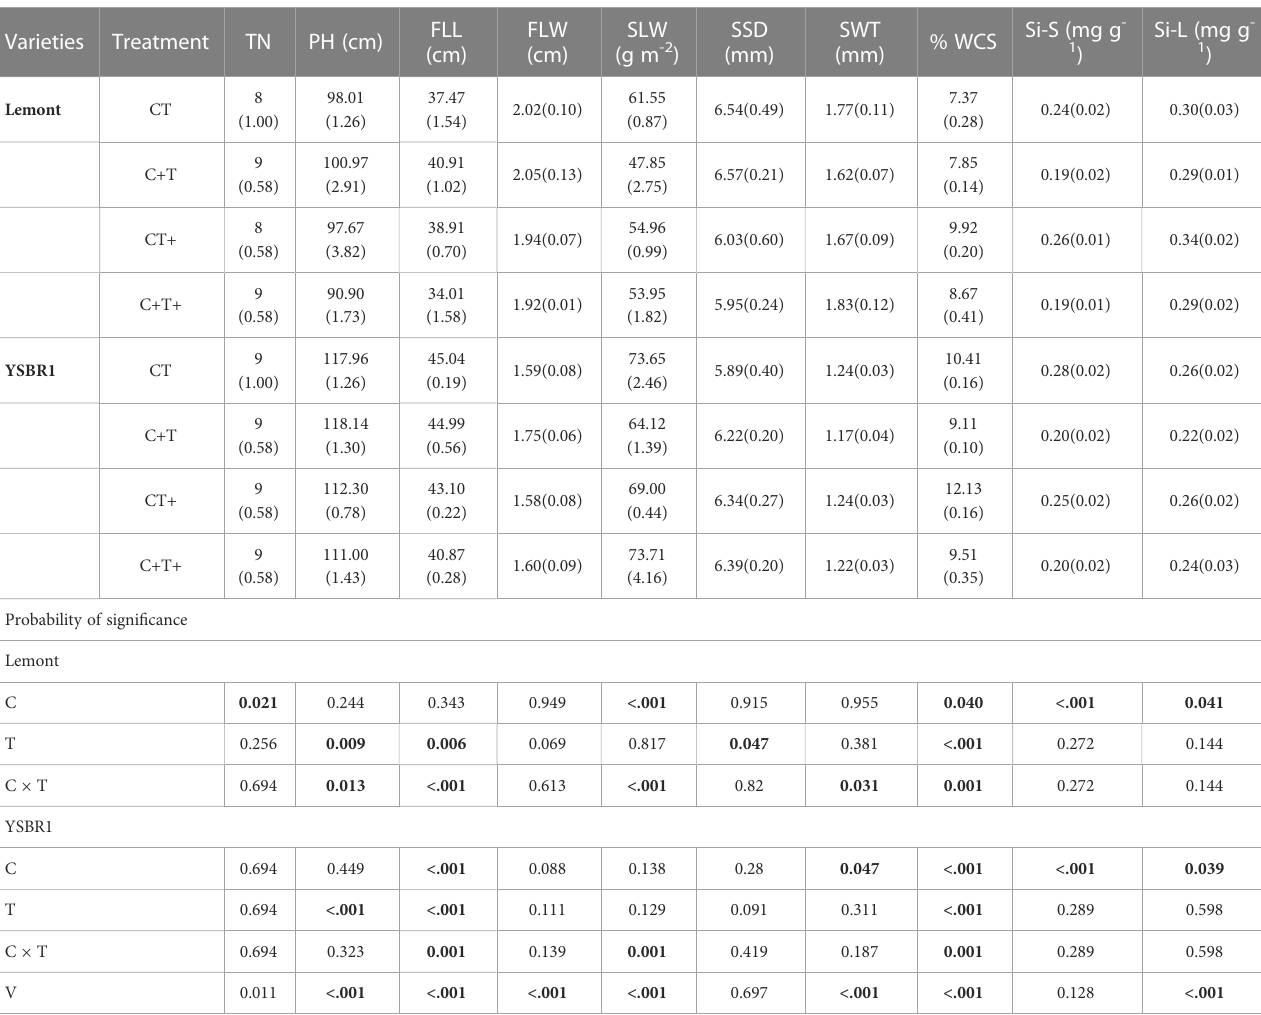
TABLE 3 Morphological parameters (SD between brackets) of uninoculated plants of cvs Lemont and YSBR1 at the booting stage under ambient condition (CT), elevated CO 2 (C+T), elevated temperature (CT+), and the combination of elevated CO 2 and elevated temperature (C+T+) in 2021 a .